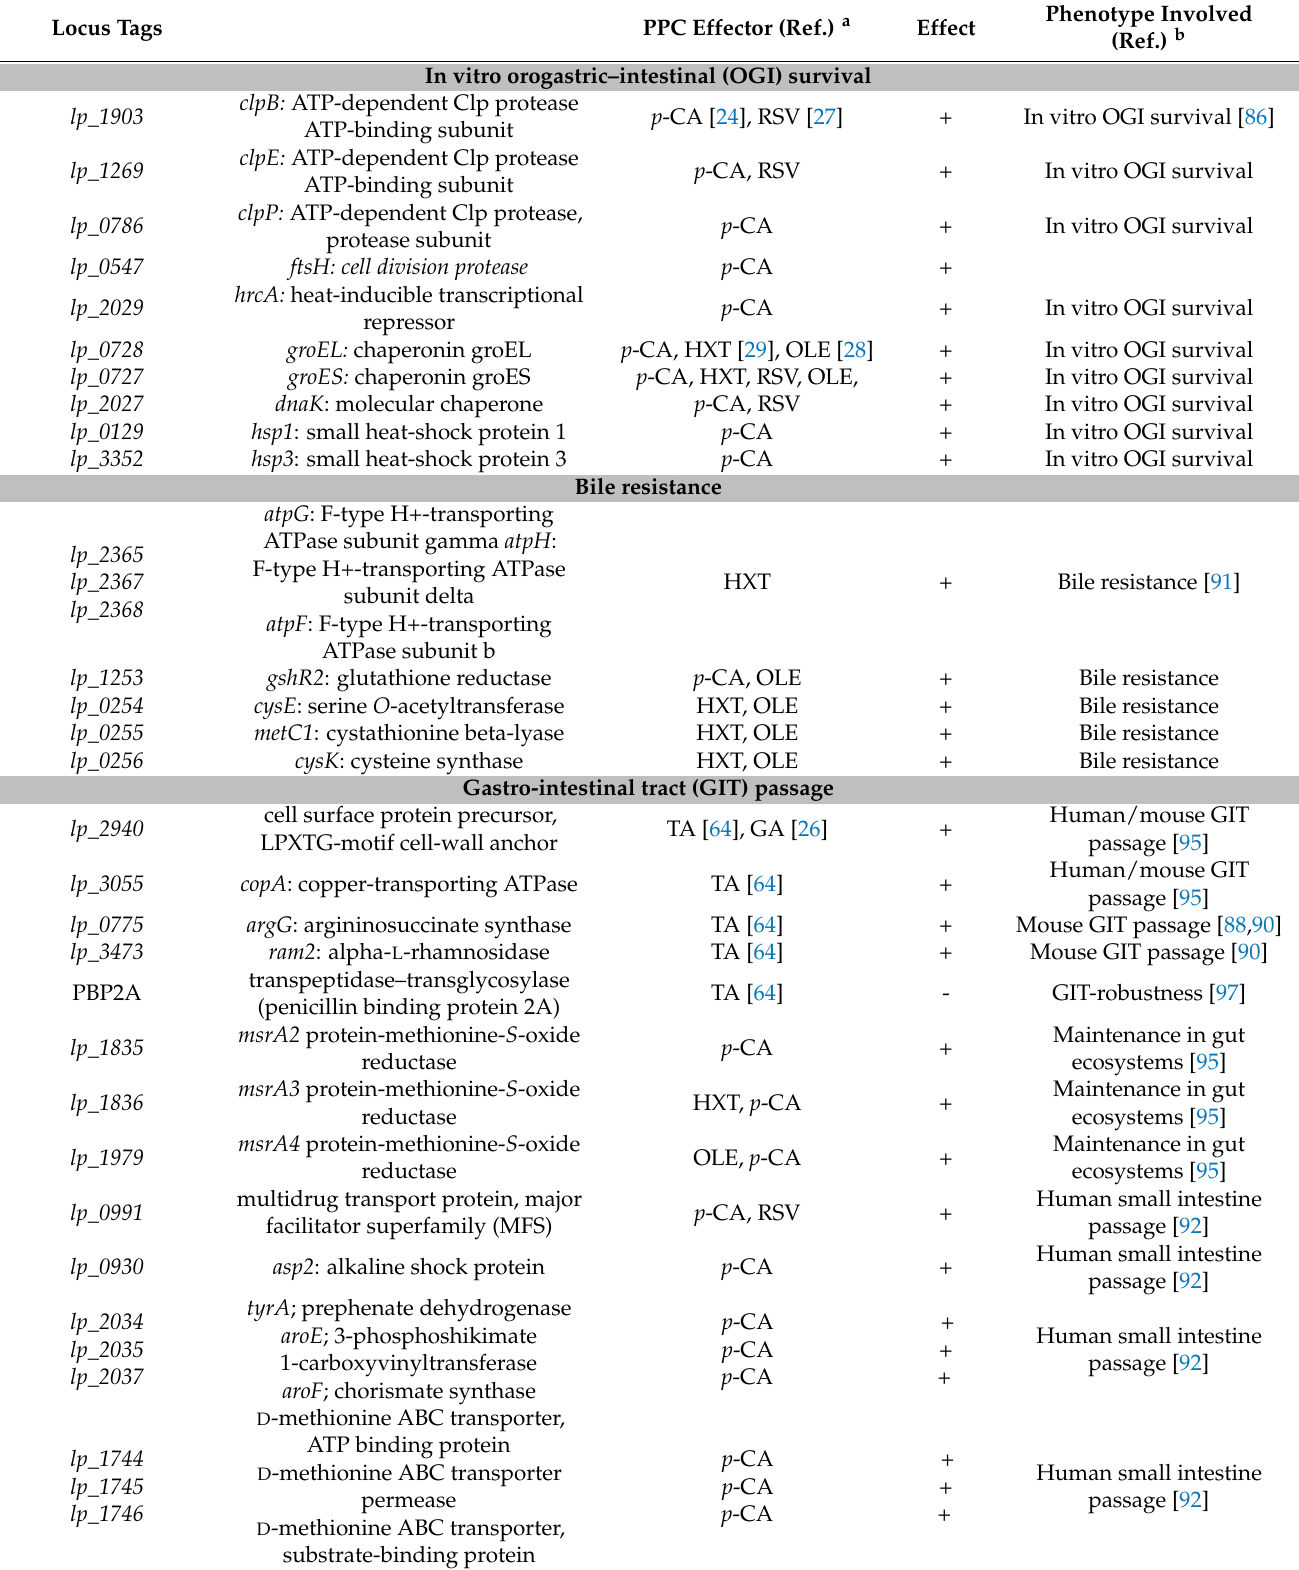
Table 3. Genes and proteins of Lactiplantibacillus plantarum WCFS1 associated with improved sur- vival against gastrointestinal tract-induced stress that are differentially expressed by plant phenolic